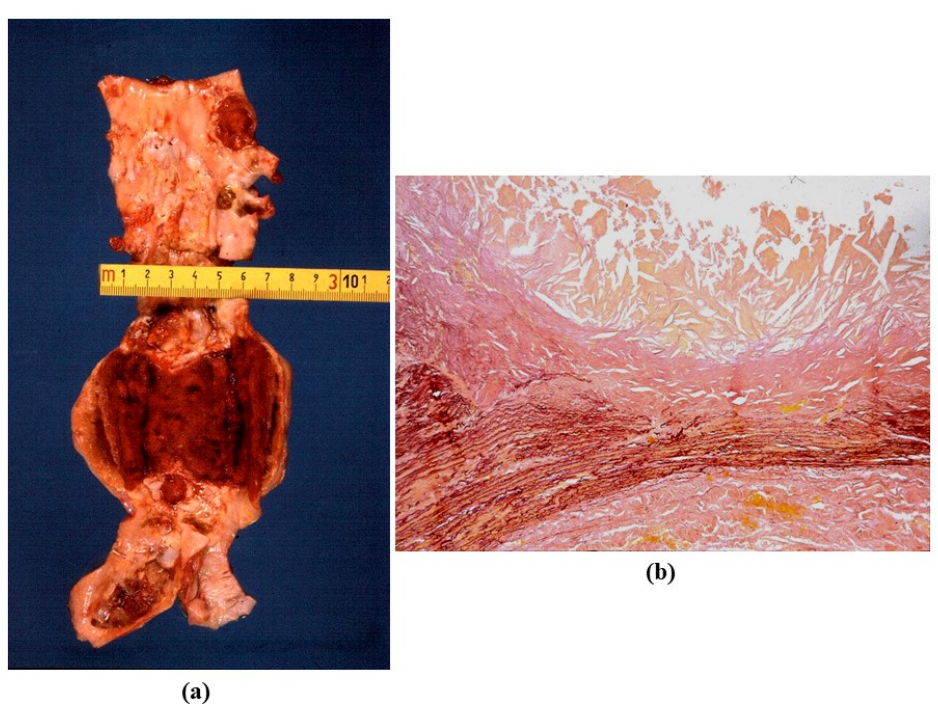
Figure 14. Atherosclerotic saccular aneurysm of the abdominal aorta. ( a ) Gross features. ( b ) Histology with atheroma disrupting the tunica media, with loss of elastic fibers and thinning. (Weigert Van Gieson stain).